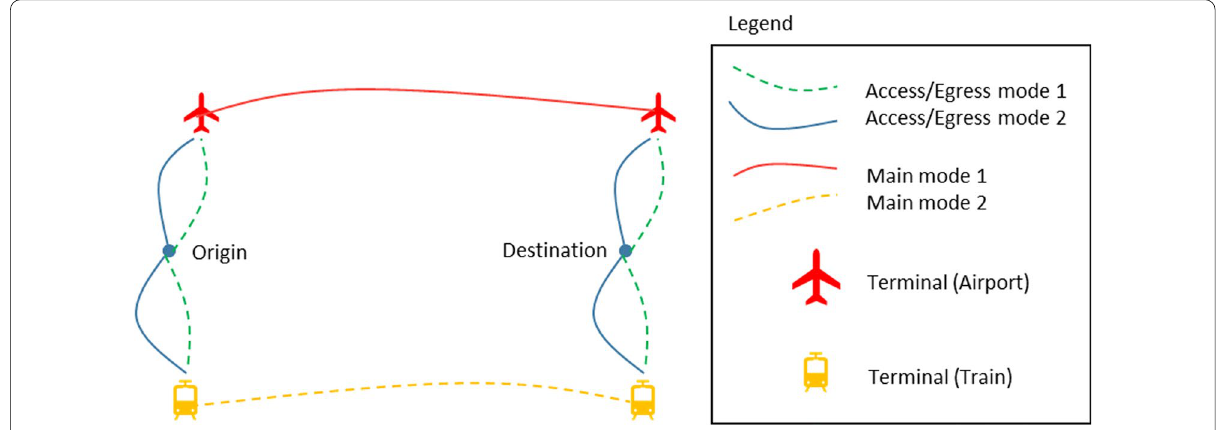
Fig. 4 Schematic figure of access and egress mode choice within main mode choice (Type